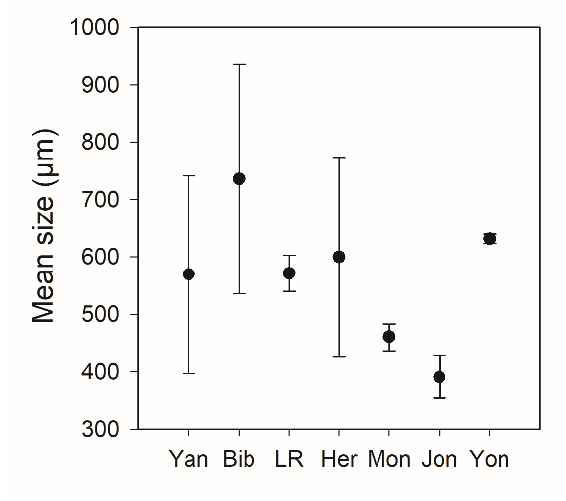
Figure 5. Mean body size averaged for each lake showing the average smallest and largest size from three to four sampling points at each lake; all sizes are in µm equivalent spherical diameter (ESD). Study lakes are indicated along the x -axis with Yan = Yangebup, Bib = Bibra, LR = Little Rush, Her = Herdsman, Mon = Monger, Jon = Joondalup, and Yon =